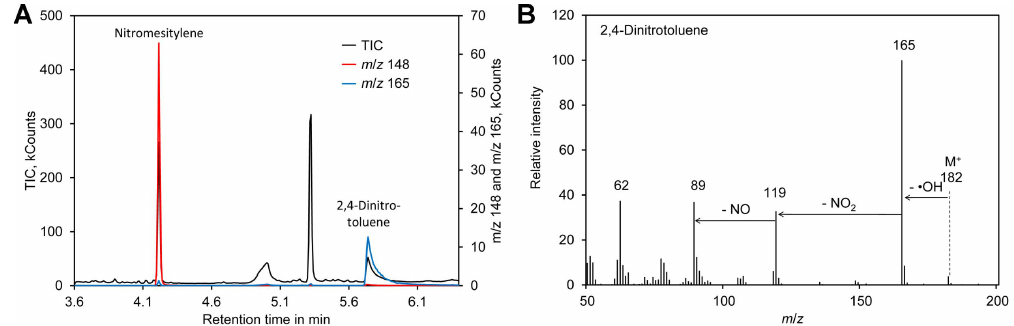
Figure 3. 2,4-Dinitrotoluene as internal standard. ( A ) Chromatogram obtained by derivatization of [ 14 N]-nitrate with nitromesitylene containing 0.5 mM 2,4-dinitrotoluene. ( B ) Mass spectrum of 2,4-dinitrotoluene. Original data are included in Supplementary File